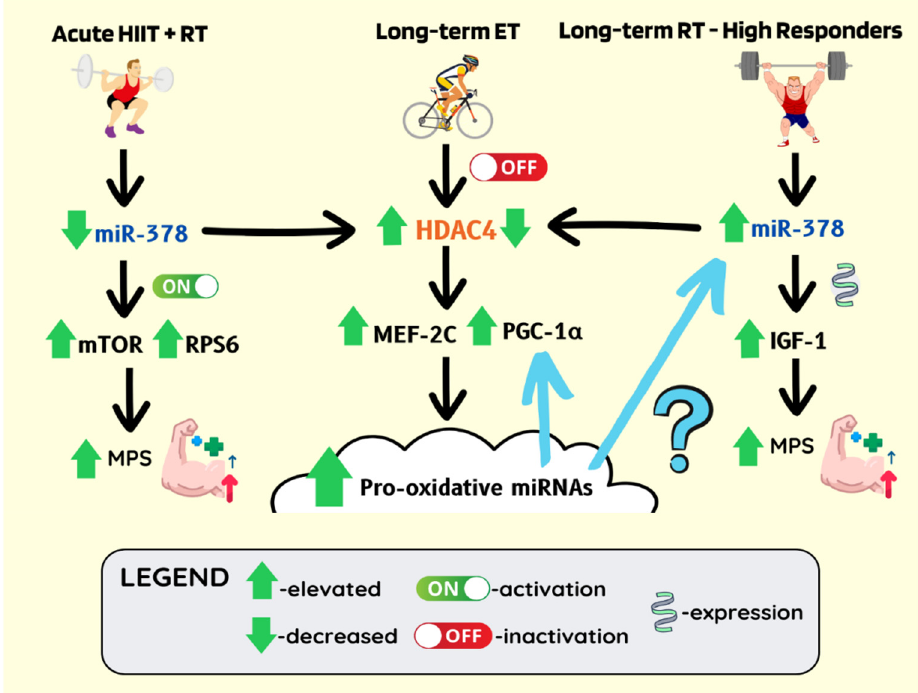
Figure 4. Long-term endurance training-induced miRNA cloud may facilitate oxidative and hyper- trophic sensitivity (exercise memory). miR-378 is significantly higher in high responders compared to low responders following 12 weeks of hypertrophy training. Anabolic responsiveness correlates with increased IGF-1 expression. ET-induced AMPK and CaMK signalling reduces HDAC nuclear abundance. Correspondingly, miR-378 downregulates HDAC4 expression. Decreased HDAC4 epigenetic activity is permissive to the expression of muscle-specific, antioxidant, mitochondrial, and pro-oxidative miRNAs genes. The pro-oxidative miRNAs may establish a positive feedback loop maintaining the expression of the slow twitch/oxidative muscle genes and potentially be re- sponsible for increased responsiveness/sensitivity to hypertrophic stimuli. The acute RT-dependent downregulation of miR-378 and subsequent increase in HDAC4 activity allows mounting of regenera- tive/inflammatory response. However, lifelong, regular aerobic training is needed to control HDAC4 activity and optimise its regulatory effects on muscle plasticity and